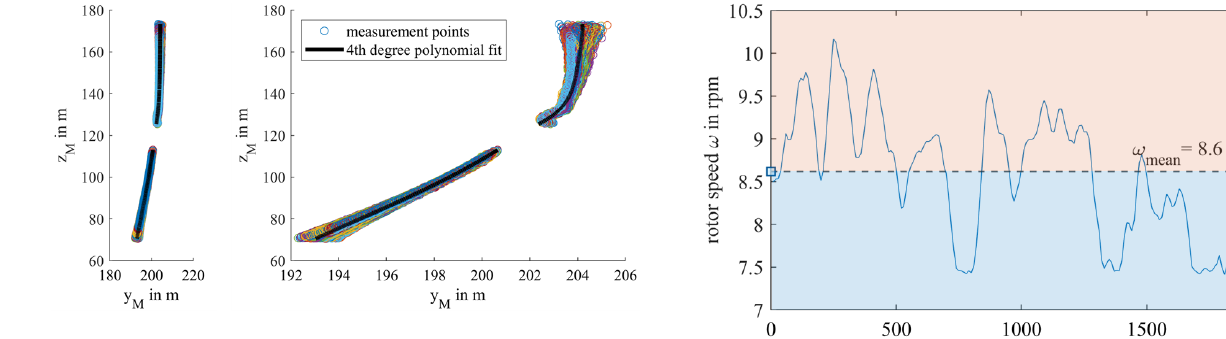
Figure 10. Measurement points on the blades as circles and fourth- degree polynomial fits for blade 1 for all rotor speeds.